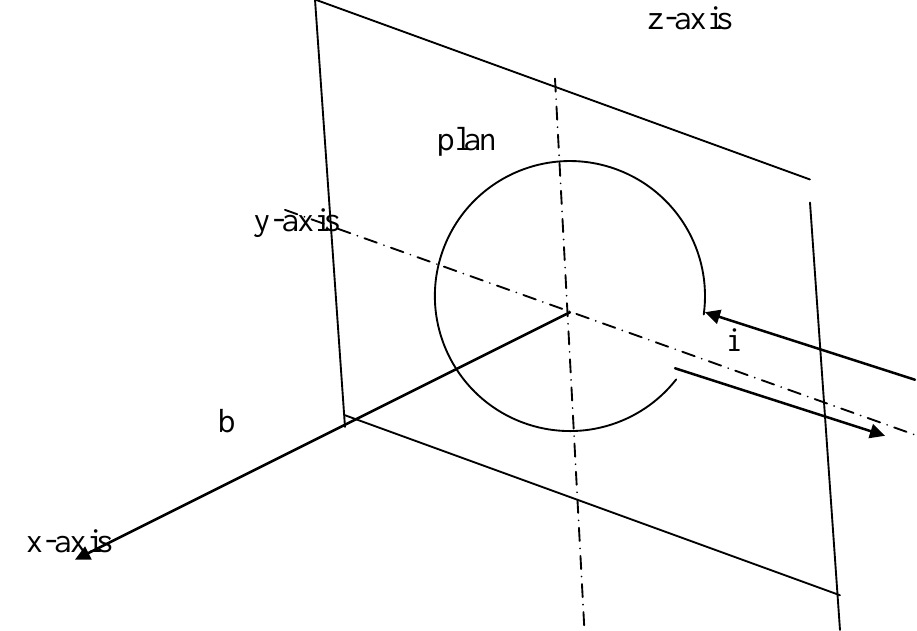
figure(2) i= current , x=axis, plan(x,y,z,) plan of magnetic coil, b= axial distance from perpendicular to turn